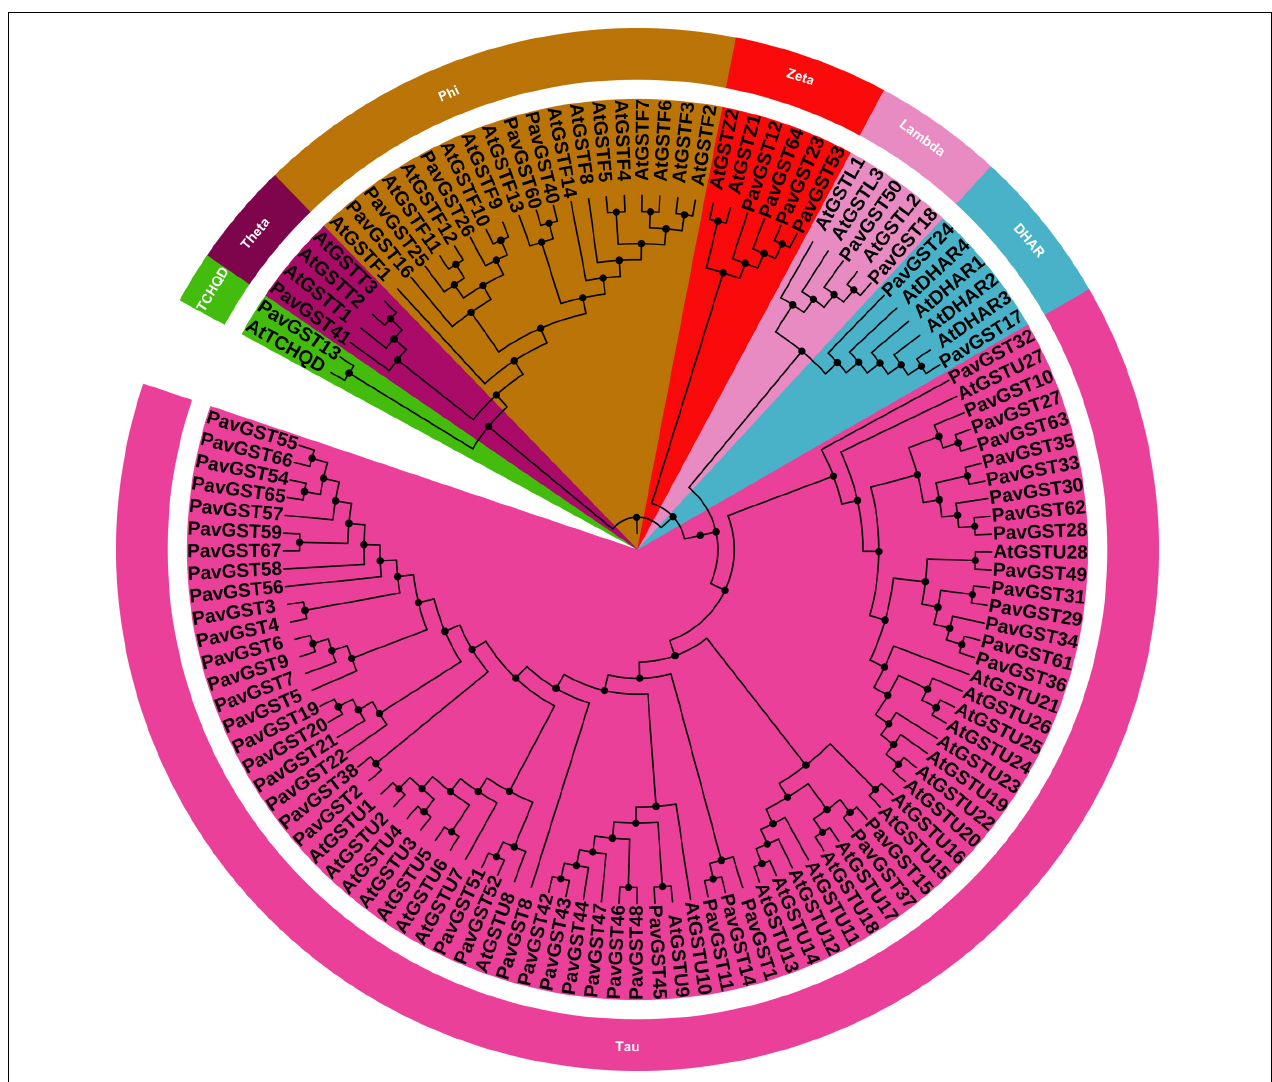
FIGURE 1 | Phylogenetic tree of glutathione S-transferase (GST) gene family of P. avium and Arabidopsis thaliana . Each color representing a subfamily (TCHQD, Theta, Phi, Zeta, Lambda, DHAR and Tau) of GST genes and itol was used to construct the phylogenetic